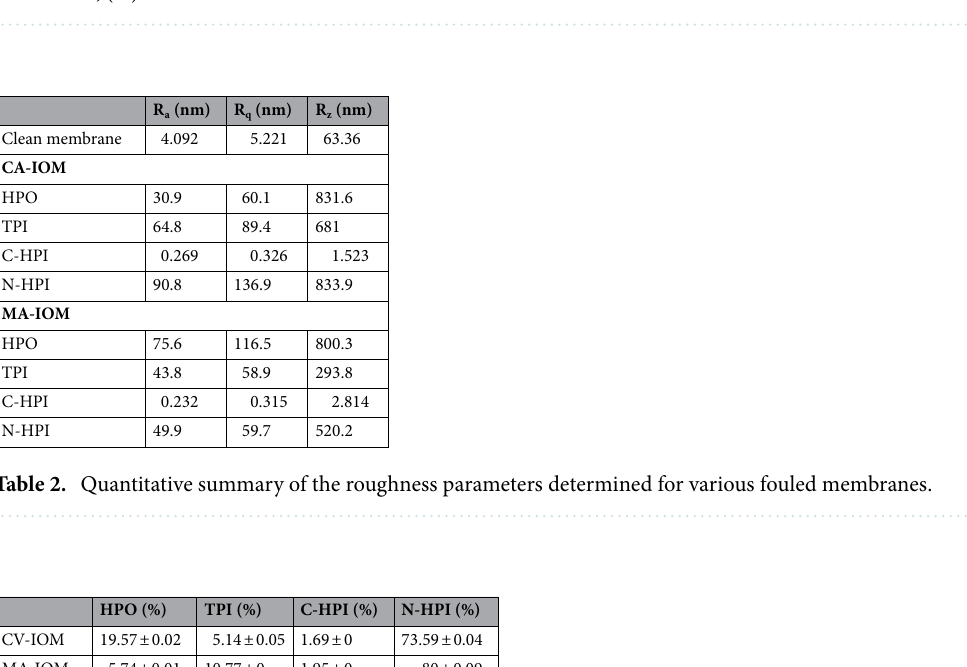
Figure 5. AFM images of the clean and fouled membrane surfaces when filtering various IOM filtrations, ( O ) clean membrane, ( A ) CV-HPO, ( B ) CV-TPI, ( C ) CV-C-HPI, ( D ) CV-N-HPI, ( E ) MA-HPO, ( F ) MA-TPI, ( G ) MA-C-HPI, ( H ) MA-N-HPI.